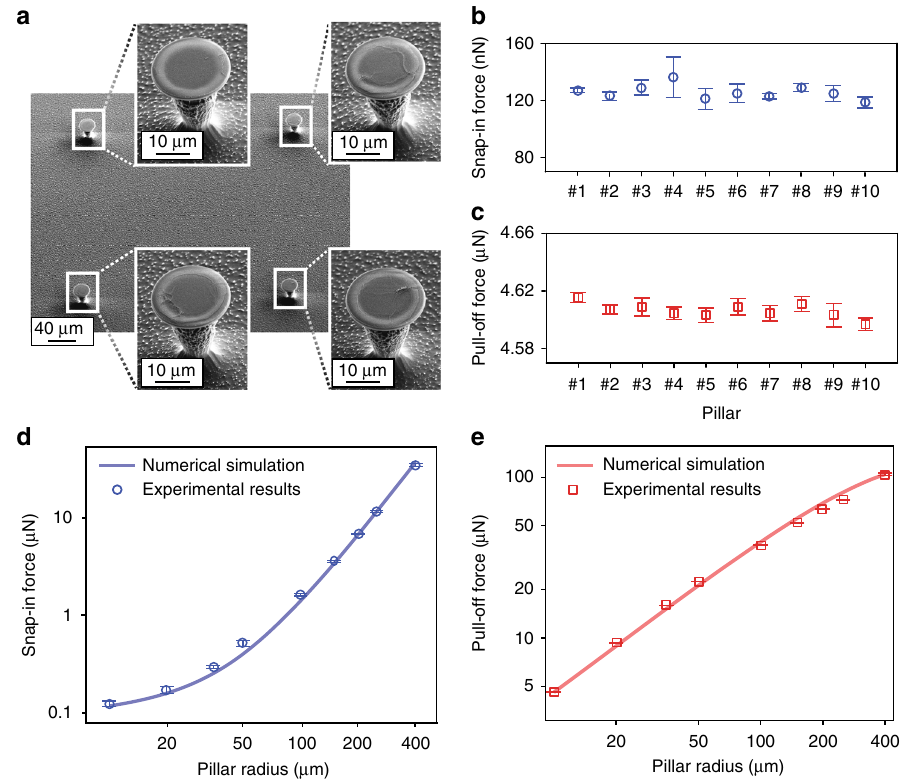
Fig. 2 Accuracy and repeatability of droplet adhesion force measurements. Silicon micropillars with undercut tops were used for the accuracy and repeatability measurements. a SEM micrographs of four different 10 µ m radius pillars showing tiny structural variations on the pillar tops. b , c Snap-in and pull-off force data from ten different 10 µ m radius pillars. Data for 20 – 50 µ m radius pillars are in Supplementary Fig. 2. d , e Snap-in and pull-off forces as function of pillar radius, the number of data points was 100 (10 – 50 µ m radius pillars) or three (100 – 400 µ m radius pillars). Solid lines show numerical simulation results. Error bars denote standard deviations in